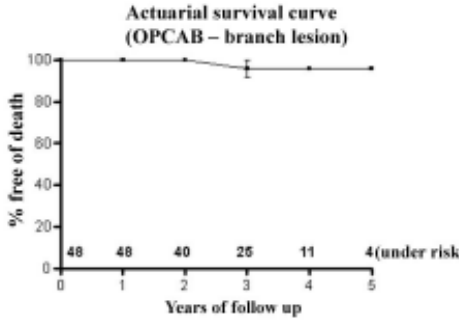
obtained a greater survival rate. MEHARWAL et al. [21] obtained promising results with OPCAB in high-risk patients with multiple arterial coronary disease. A retrospective comparative study demonstrated that the mortality until 30 days was 1% with an OPCAB group and 4.7% with a CPB group in patients from a left coronary artery branch lesion subgroup [22]. artery branch presenting with hemodynamic stability and